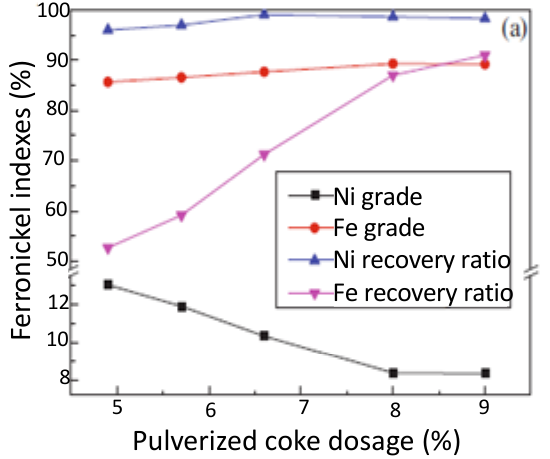
Figure 3. Ni and Fe recovery rate and recovery ratio (modified from [7]).